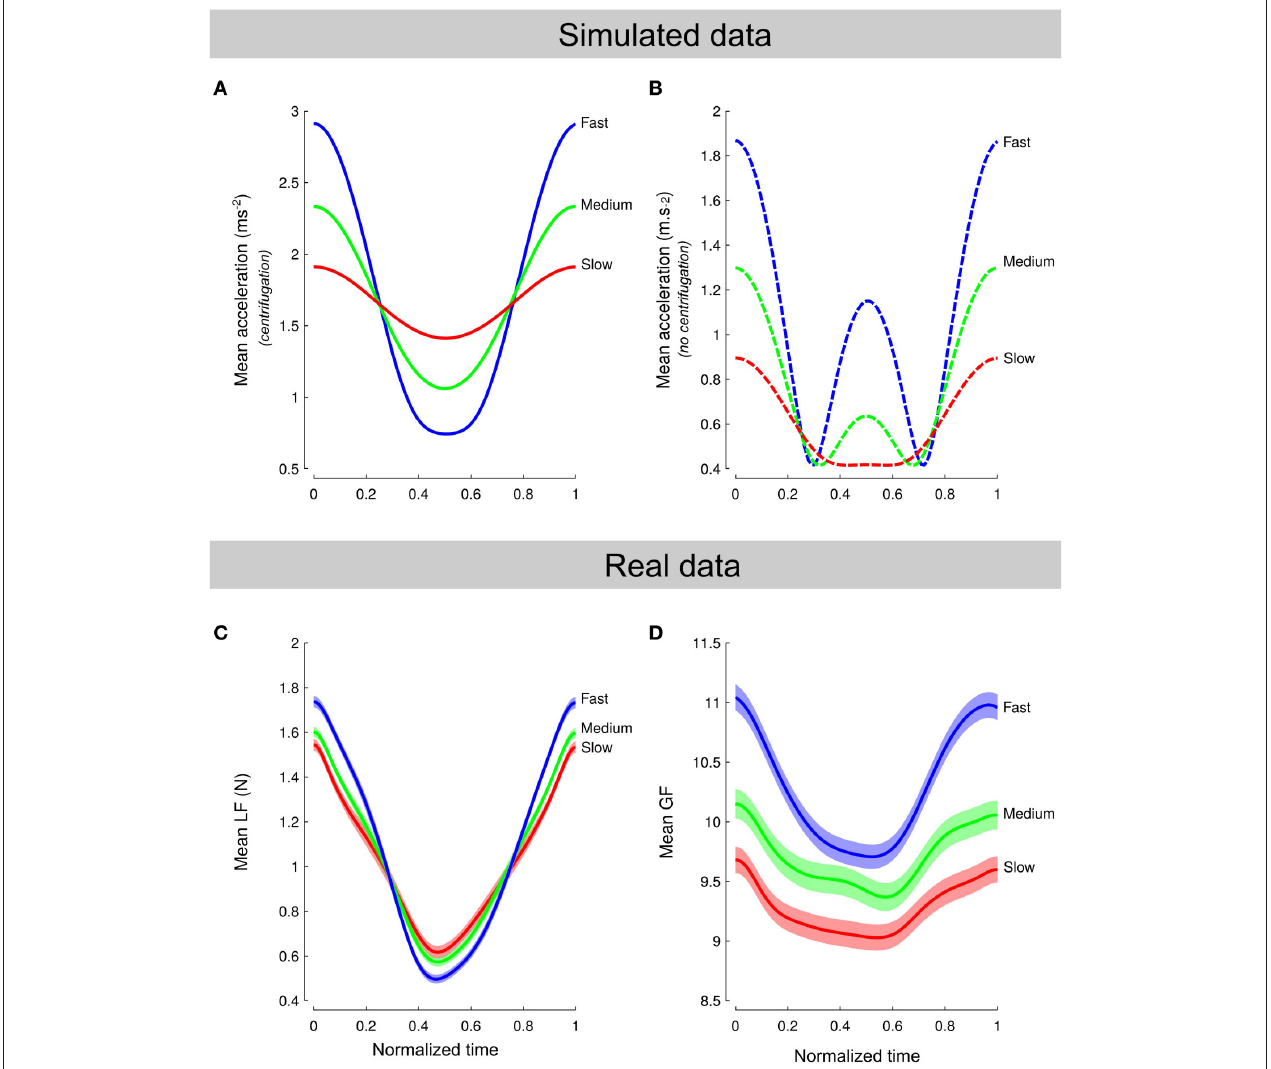
FIGURE 4 | Comparison between model and data. (A,B) Simulated load force over normalized time when the model takes into account the effect of the rotation on the object (A) or not (B) . Colored lines correspond to a different frequency. (C,D) Actual averaged load force cycles (C) and grip force cycles (D) normalized across all conditions. Note that the pattern of load forces in (C) span a shorter force amplitude than simulated accelerations in (A) because the object mass was